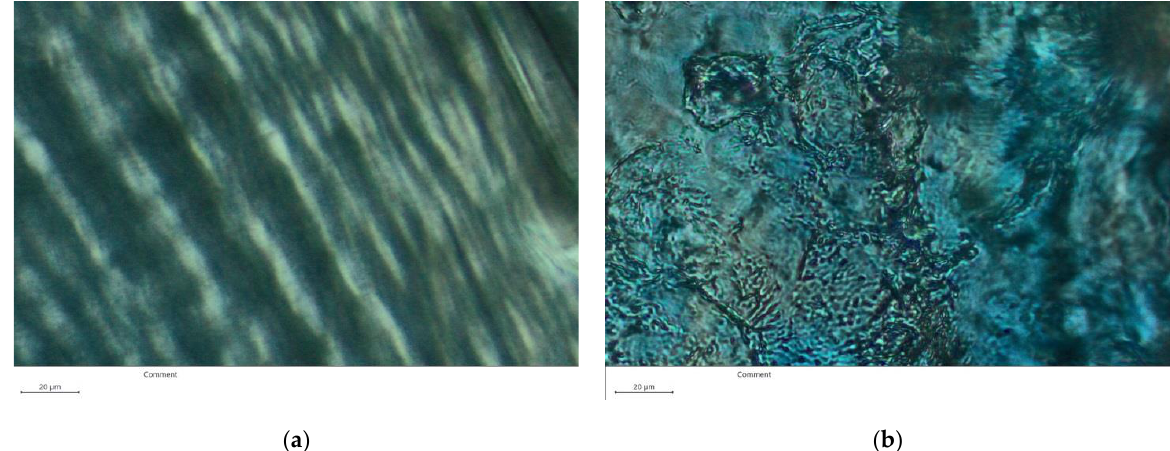
Figure 5. POM images of ( a ) C1 and ( b ) C5 films.